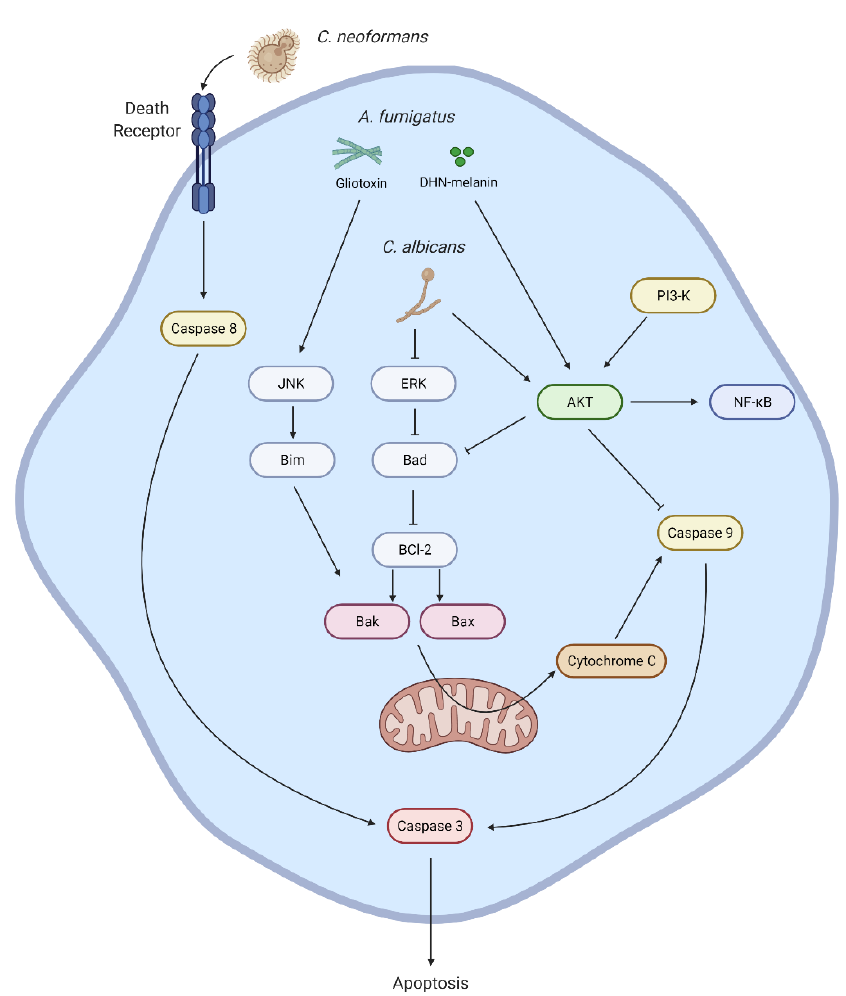
Figure 1. Fungal induction of apoptosis. The modulation of the extrinsic and intrinsic pathway of apoptosis depends on the type of fungal virulence factor intervening. C. neoformans ’ capsular polysaccharides bind to cell death receptors, triggering extrinsic pathway via caspase-8 activation. Likewise, intrinsic pathway of apoptosis is induced by virulence factors in A. fumigatus and Candida sp. via modulation of B cell lymphoma 2 (BCL2) homology 3 (BH3)-only proteins Bim and Bad, respectively. Alternatively, the inhibition of apoptosis has also been described as a strategic mechanism for pathogen survival, mediated by the upregulation of Akt activity and inhibition of caspase-9. The activation of apoptosis by Cryptococcus neoformans is mediated by capsular